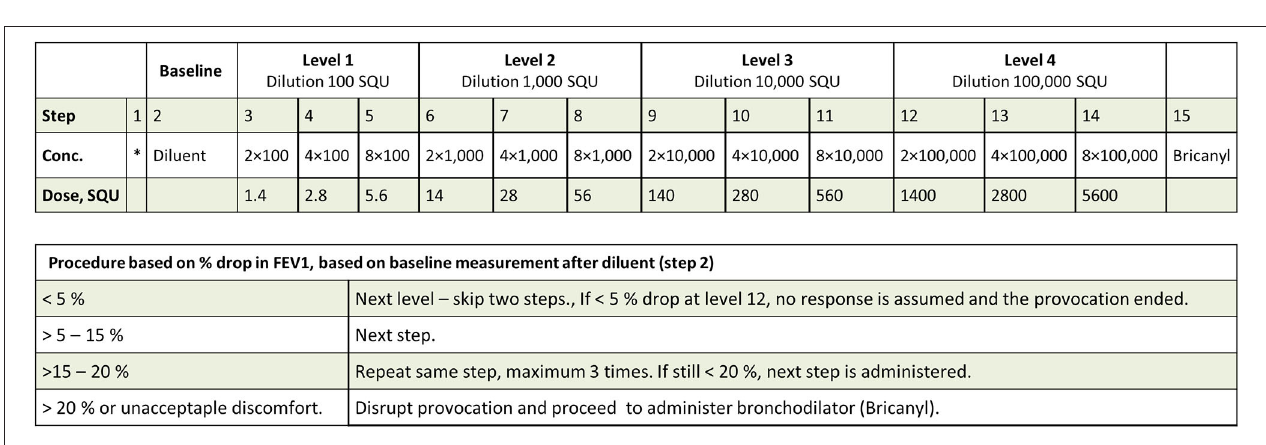
FIGURE 2 | Protocol for the SICs. The administered dose is dependent on the magnitude of the drop in forced expired volume in the first second (FEV 1 ) induced by the previous dose, resulting in either one step or one level increase in